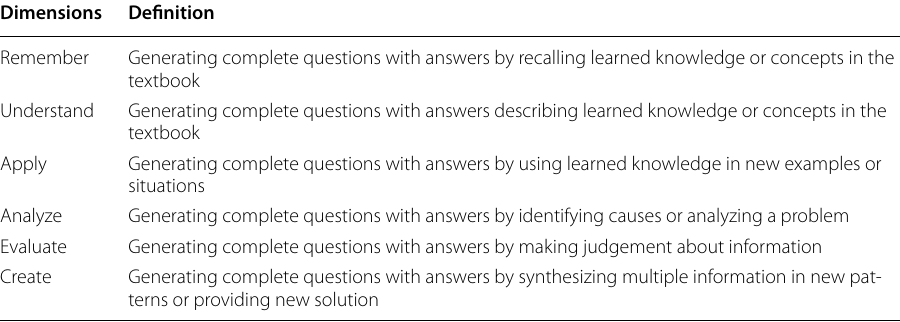
Table 1 Criteria for classifying the cognitive level of